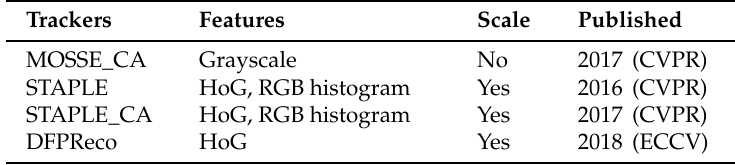
Table 1. Baseline trackers that are extended with the proposed global motion estimation method. The type of features, scale estimation, and year of publication are given for each